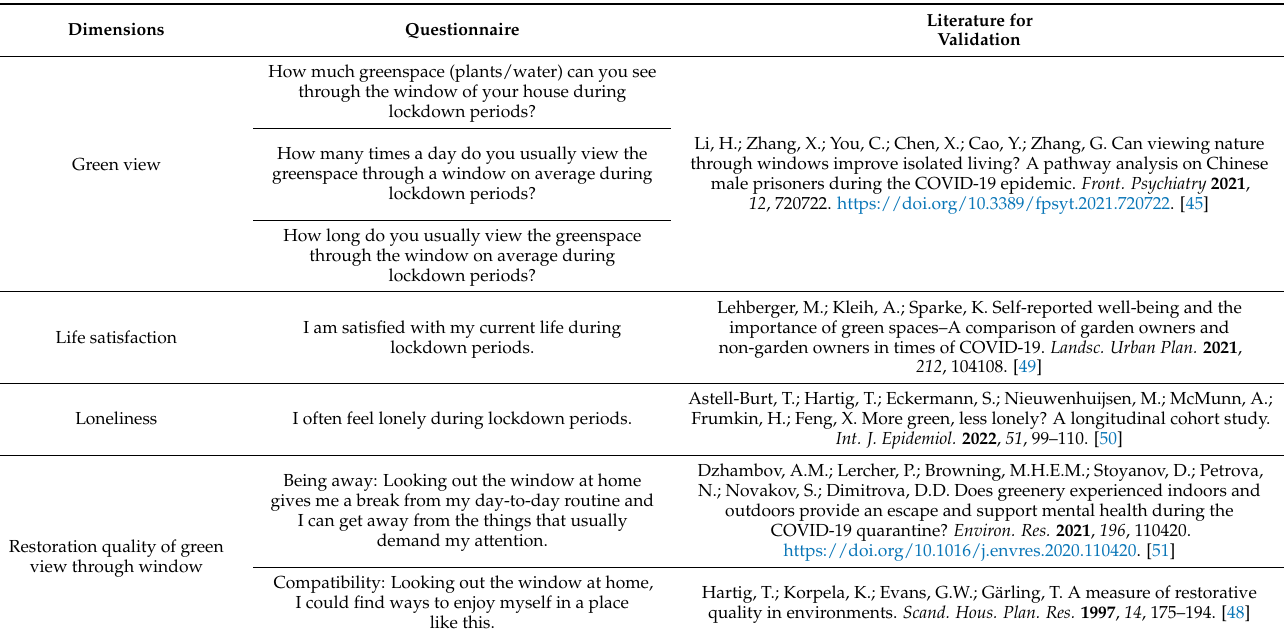
Table 1. Questionnaire